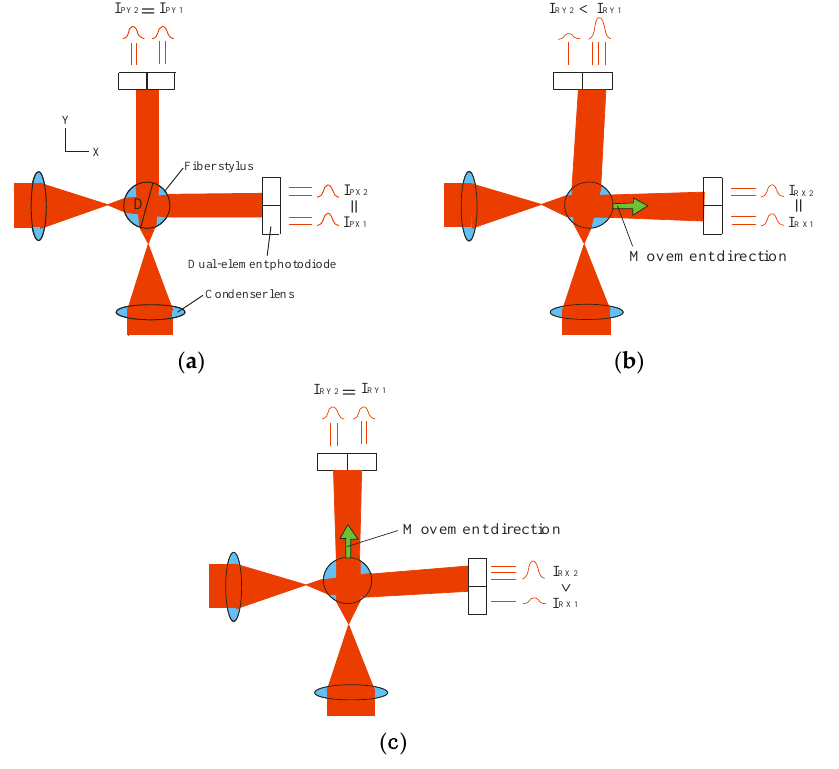
Figure 2. Principle of measurement. ( a ) Initial stage; ( b ) displacement in the X-direction; ( c ) displacement in the Y-direction.